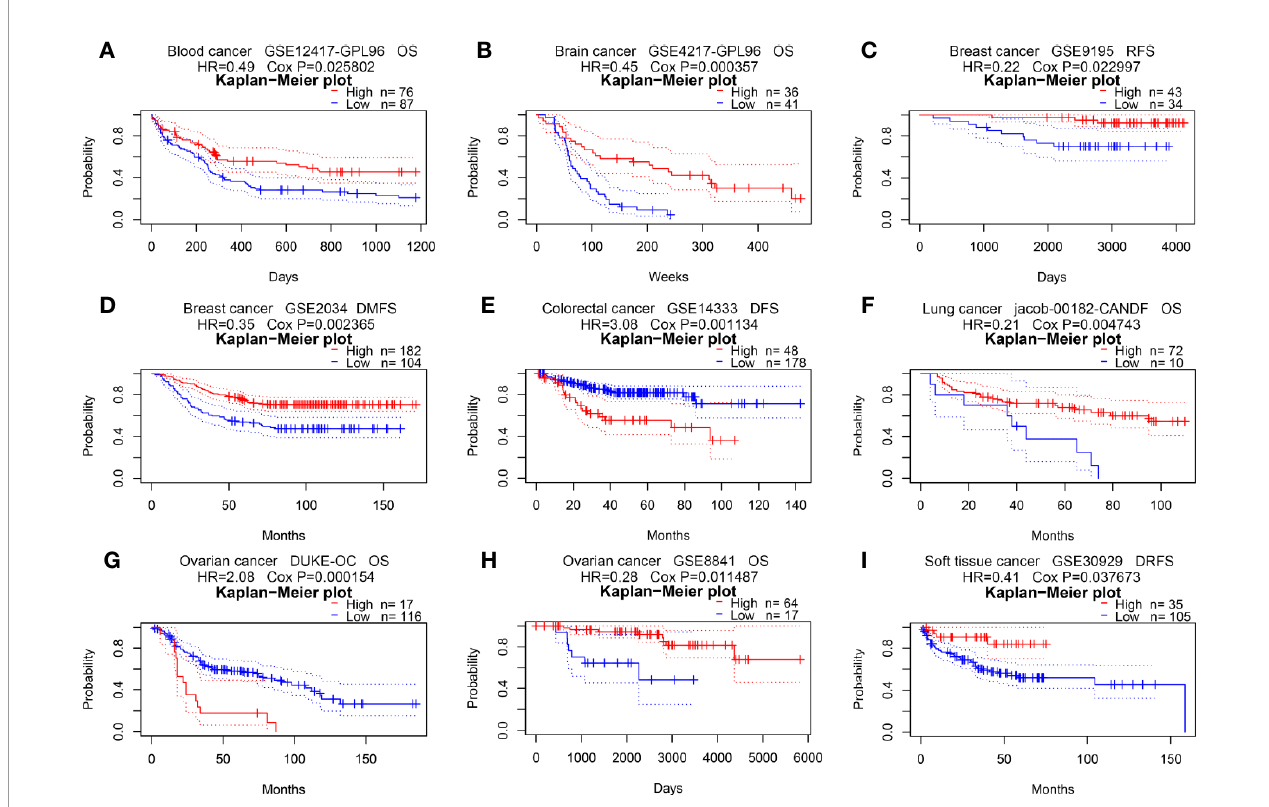
FIGURE 2 | Survival analyses of PINK1 expression in pan-cancers (based on PrognoScan). (A) OS (n = 163) in blood cancer cohort GSE12417-GPL96. (B) OS (n = 77) in brain cancer cohort GSE4217-GPL96. (C) RFS (n = 77) in breast cancer cohort GSE9195. (D) DMFS (n = 286) in breast cancer cohort GSE2034. (E) DFS (n = 226) in colorectal cancer cohort GSE14333. (F) OS (n = 82) in lung cancer cohort jacob-00182-CANDF. (G) OS (n = 133) in ovarian cancer cohort DUKE-OC. (H) OS (n = 81) in ovarian cancer cohort GSE8841. (I) DRFS (n = 140) in soft tissue cancer cohort GSE30929. OS, overall survival; DMFS, distant metastasis free survival; RFS, relapse free survival; DFS, disease free survival; DRFS, distant recurrence free